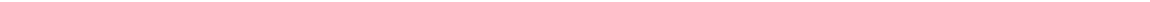
Fig. 3 Nr2f6 expression alters gene signature of tumor-reactive T cells. a Principal component analyses of the RNA-seq data from pre-sorted CD3 + tumor- in fi ltrating T cells of Nr2f6 + / + IgG2b ( n = 3), Nr2f6 + / + α PD-L1 ( n = 5), Nr2f6 − / − IgG2b ( n = 3) and Nr2f6 − / − α PD-L1- ( n = 5) treated tumor-bearing mice taken at d14 after tumor injection of 5×10 5 B16-OVA melanoma cells separates the TILs into four distinct clusters. b − d ClueGO analysis of up- and downregulated genes in isolated TILs from combinatorial NR2F6/PD-L1 therapy groups. CD3 + TILs from either Nr2f6 + / + or Nr2f6 − / − mice with PD-L1 blockade therapy were isolated, RNA-seq was performed and the signi fi cantly differentially expressed genes were subsequently analyzed using ClueGO. The enriched gene ontology terms are shown as functionally grouped nodes in an interconnected network based on their score level. The sizes of the nodes re fl ect the enrichment signi fi cance of the terms, while functionally related groups partially overlap. Terms with up-/downregulated genes are shown in green/red, respectively. The color gradient shows the gene proportion of each group (up- or downregulated group of genes) associated with the term. Equal proportions of the two groups are represented in gray. The pie charts show the enriched groups represented by the most signi fi cant term. The sizes of the sections correlate with the number of terms included in a group. The key upregulated pathways ( c ) in TILs from Nr2f6 − / − mice with PD-L1 blockade are: cell-mediated cytotoxicity ( p = 0.0001), IFN γ signaling ( p = 0.0004), TCR signaling pathway (p = 0.0006), immune system function ( p = 0.0009), Wnt signaling pathway ( p = 0.0029), type II IFN signaling ( p = 0.0042), TNF signaling pathway ( p = 0.0045). e GSEA enrichment plot of KEGG endometrial cancer pathway genes of sorted CD3 + TILs from Nr2f6 + / + α PD-L1 versus Nr2f6 − / − α PD-L1-treated tumor-bearing mice. Genes in the KEGG endometrial cancer signaling pathway showed signi fi cant enrichment in T cells and CD4 Th1 signature (FDR q value = 0.006). The top portion of the fi gure plots the enrichment scores (ES) for each gene, whereas the bottom portion of the plot shows the value of the ranking metric moving down the list of ranked genes. f Heat map showing most prominent deregulated genes: Nfatc1; Nfatc2; Klrc2; Cd48; Klra3; Ppp3cc; Klrd1; Socs3; Stat1; Camk2b; Cd28; Il10; Prkcq; Adcy7; Hectd3; H2-DMa; Dapp1; Rps6kb2; Cybb; Ripk3; Tnfaip3; Prkacb; Zbp1; Junb;